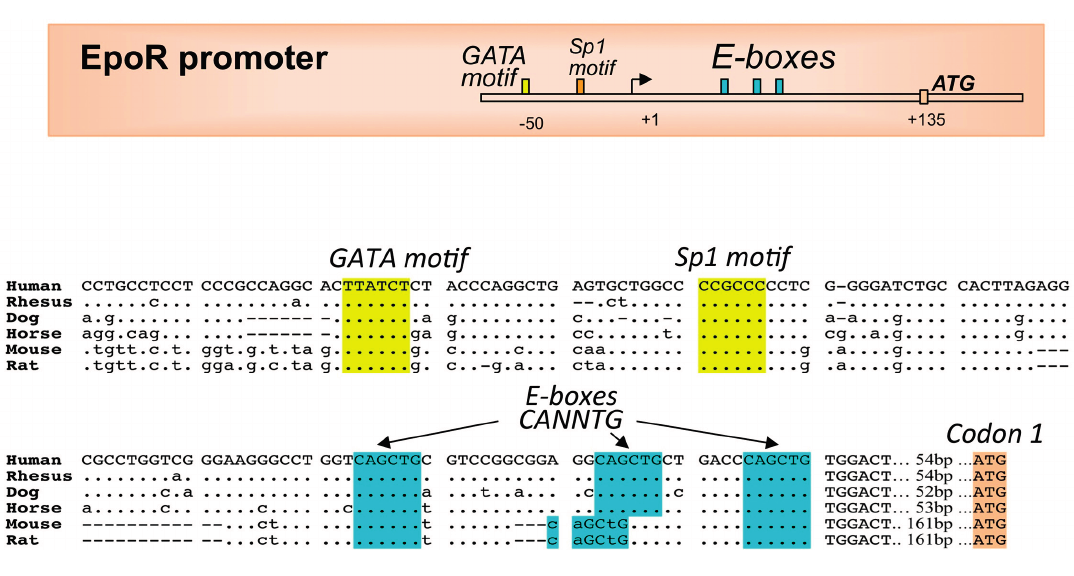
Figure 2. EpoR gene proximal promoter region with conserved regulatory protein binding sites. Top panel , schematic of the human EpoR proximal promoter region extending to the translation start site (ATG, +135) showing conserved GATA binding motif (AGATAA), a Sp1 binding motif (CCGCCC) upstream of the transcription start site and 3-E-boxes (CAGCTG) downstream in the 5' untranslated transcribed region. The E-boxes are consensus-binding sites for bHLH transcription factors. Middle and bottom panels , homologous mammalian sequences showing alignment of conserved transcription factor binding